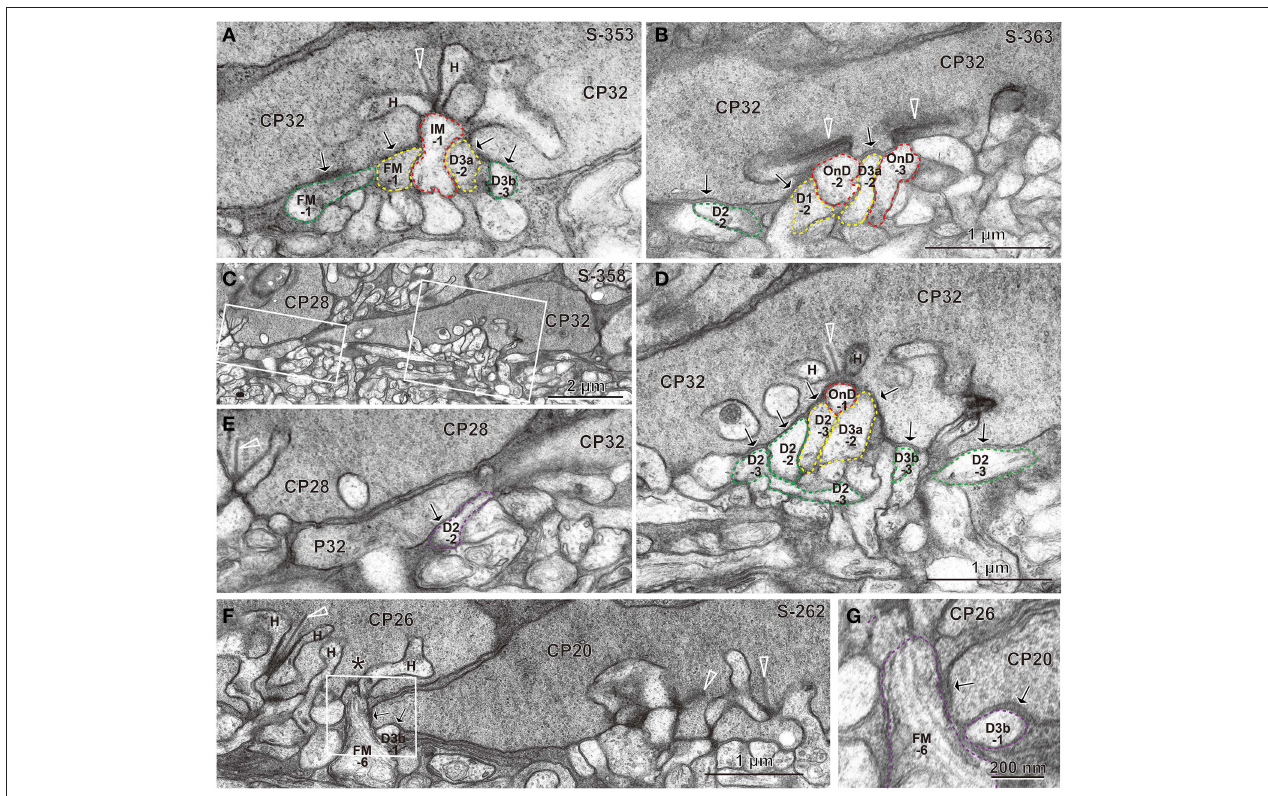
FIGURE 3 | Electron micrographs of synapses between bipolar cell dendrites and cone pedicles (CP). (A) An invaginating synapse (IMB-1 in red) of an ON MB cell under the ribbon (arrowhead) flanked by two horizontal processes (H), “TA” synapses of cells FMB-1 and DB3a-2 (in yellow), and two “middle NTA” synapses of cells FMB-1 and DB3b-3 (in green) are demarcated. (B) ON DB cells form two invaginating synapses (OnD-2 and OnD-3 in red), adjacent to which are two “TA” synapses of cells DB1-2 and DB3a-2 (in yellow). Nearby and to the left is one “middle NTA” synapse of cell DB2-2 (in green). (C) Two rectangular areas are enlarged in (D,E) . (D) An ON DB cell (OnD-1 in red contour) projects an invaginating dendrite immediately underneath a ribbon, just adjacent to which two dendrites (of cells DB2-3 and 3a-2 in yellow) form “TA” synapses. Four dendrites (of cells DB2-3, 2-2, 3b-3, and 2-3 in green) form “middle NTA” synapses, which are separated by two or more other processes from the ribbon but are still less than 1.5 µ m from it. (E) A dendrite of cell DB2-2 (in violet) forms one “marginal NTA” synaptic contact with the marginal extension of CP32. This contact is located about 3.5 µ m from the nearest ribbon of CP32 but only about 2 µ m from the nearest ribbon of CP28 (arrowhead). (F) The marginal extension of CP20 is located under CP26, where two basal contacts with CP20 are much closer to the nearest ribbon area ( * ) of CP26 than that of CP20. The rectangular area is enlarged in (G) . (G) “Marginal NTA” synapse of cells FMB-6 and DB3b-1 with CP20. S-353 stands for section 353 etc. Bipolar letterings are abbreviated without